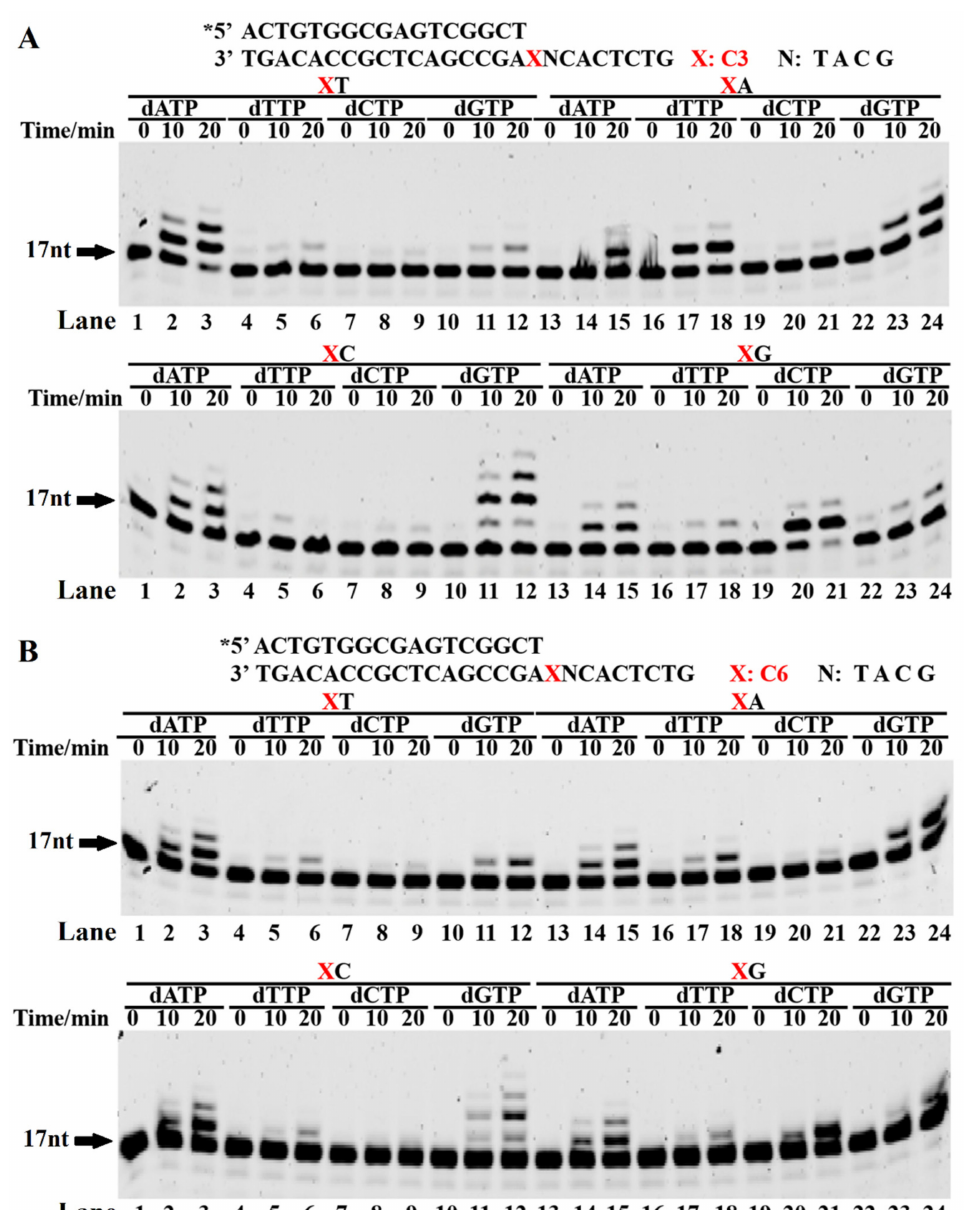
Figure 2. Single dNMP incorporation during AP site bypass. The PT DNA substrates are shown at the top of the figure, where the letter X denotes spacers C3 ( A ) and C6 ( B ). The first base upstream of the AP site in the template strand is A, T, C, or G. The PT DNA substrates were incubated with 0.1 µ M Dbh in the presence of dATP, dCTP, dGTP or dTTP at 45 ◦ C for 0, 10, 20, and 60 min. Asterisks denote the terminal fluorescent group